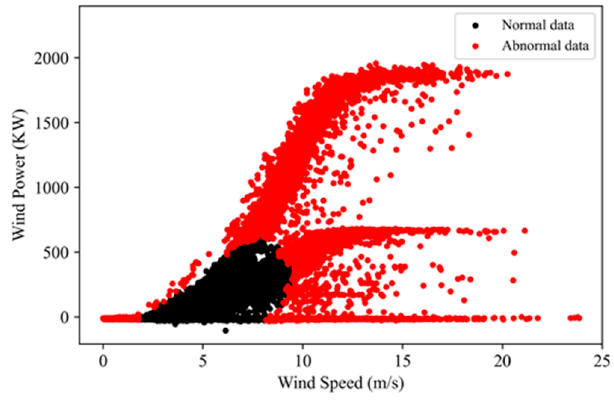
Figure 2. Abnormal data processed by I-Forest in global detection.